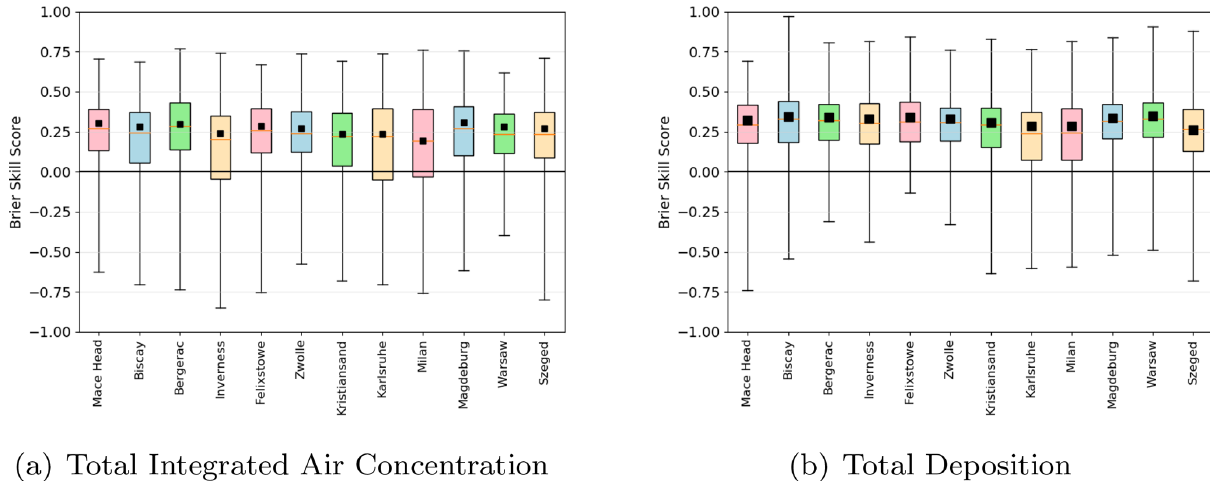
Figure 5. Adjusted Brier skill score for (a) total integrated air activity of Cs-137 above 50kBqsm − 3 and (b) total accumulated deposits of Cs-137 above 5kBqm − 2 for each of the 12 release locations. Black squares show average Brier skill scores at each location and the box and whiskers show the range of adjusted skill scores for each individual